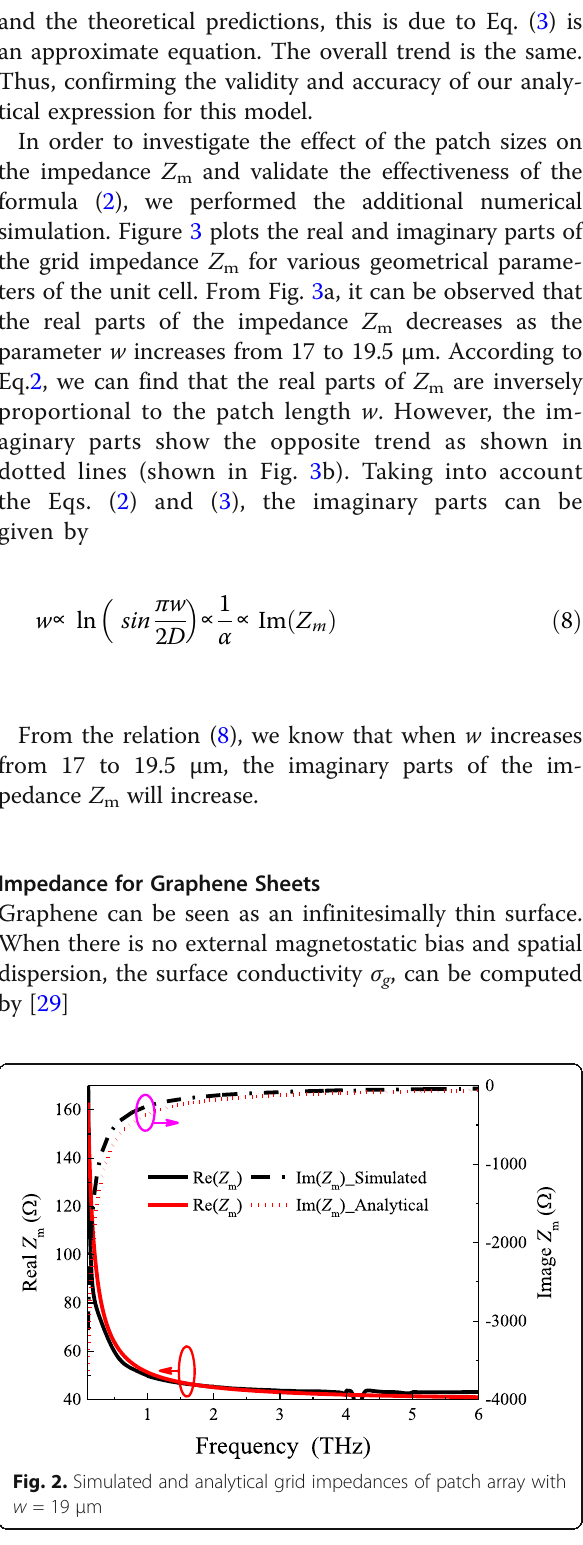
Fig. 2. Simulated and analytical grid impedances of patch array with w = 19 μ